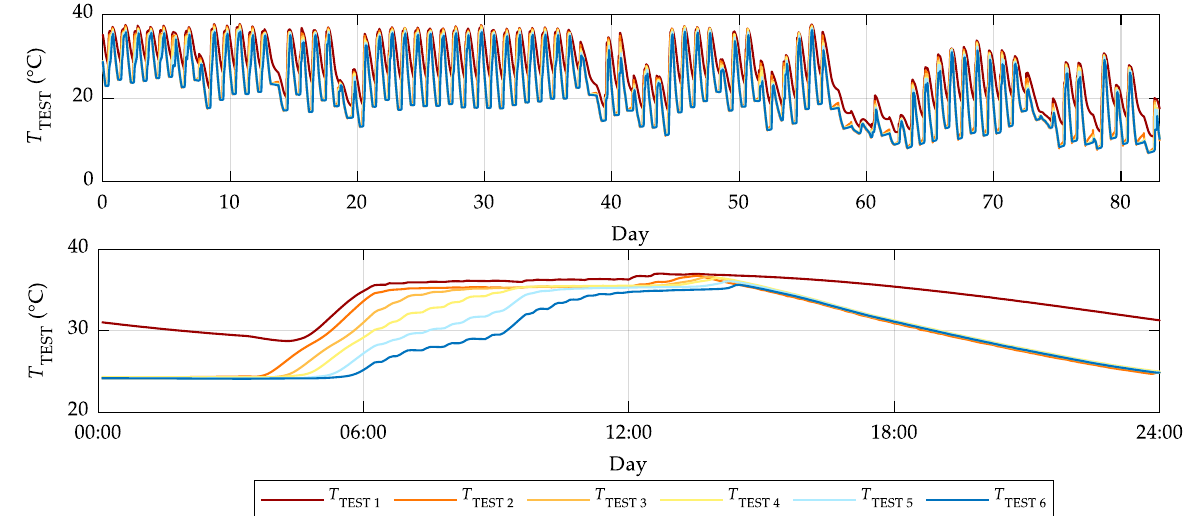
Figure 7. Temperature measurements of the working medium within the TEST at six different heights for 83 days (from August to October 2021).